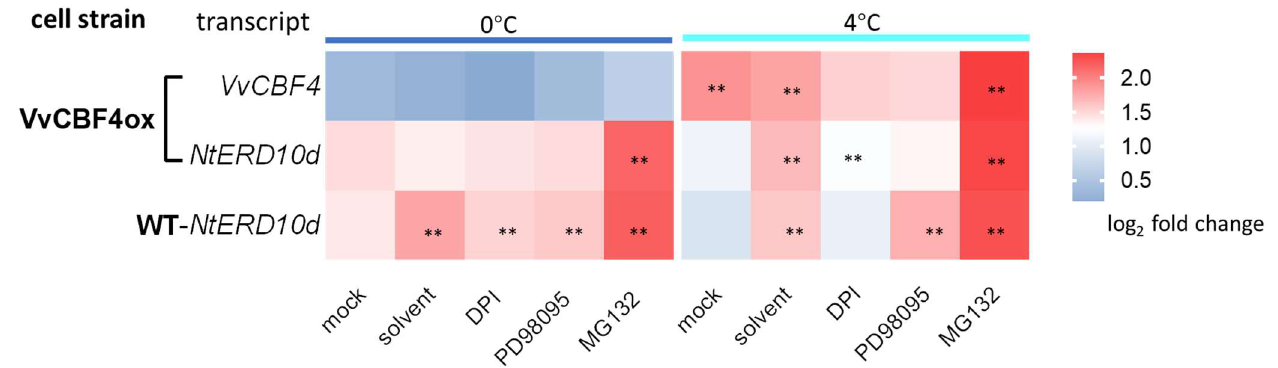
Figure 7. Response of transcripts for VvCBF4 (in tobacco VvCBF4ox cells) and NtERD10d (in both, VvCBF4ox and non-transformed BY-2 cells, WT) to 24 h of freezing (0 ◦ C) or chilling (4 ◦ C) stress after pre-treatment for 30 min with either 10 µ M Diphenyleneiodonium (DPI, inhibiting the NADPH oxidase respiratory burst oxidase homologue), 100 µ M PD98059 (inhibiting MAPK signalling), or 100 µ M MG132 (inhibiting the proteasome). For the solvent control, cells were pre-treated with 1% ( v / v ) DMSO in the same volume in treatments. The mock control consisted in an experiment, where the cells were subjected to the respective cold stress for 24 h in the absence of any inhibitor. Data are normalised to the expression levels under room temperature without any of the inhibitors from the three independent experiments in technical triplicate. Asterisks represent statistically significant differences in the LSD test ( p < 0.01).